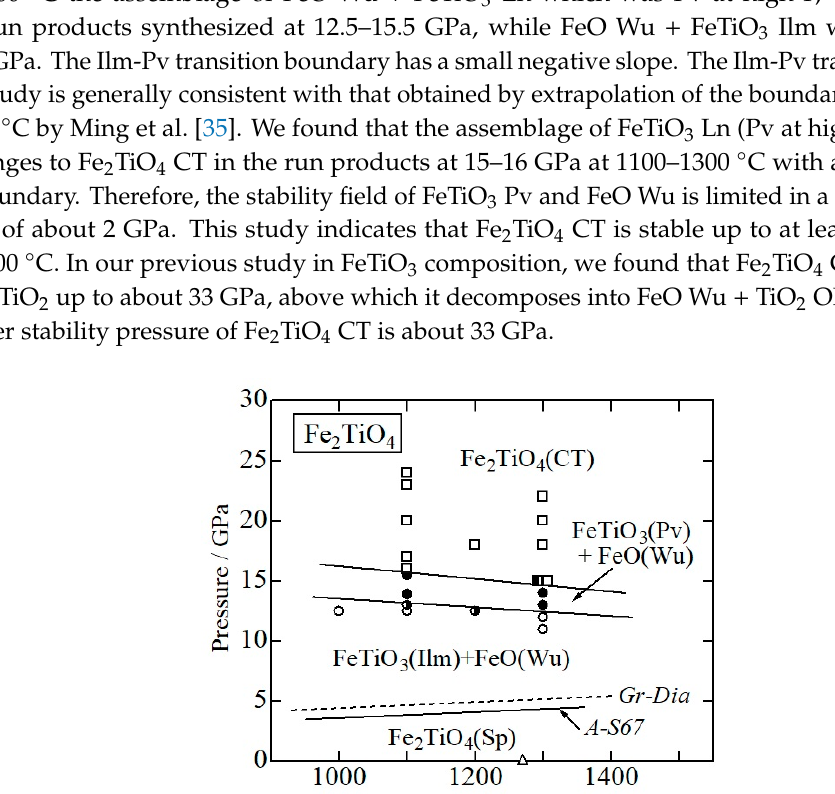
Figure 4. Phase diagram of Fe 2 TiO 4 . An open triangle: Fe 2 TiO 4 (Sp), open circles: FeTiO 3 (Ilm) + FeO(Wu), solid circles: FeTiO 3 (Pv) + FeO(Wu), open squares: Fe 2 TiO 4 (CT). Thick solid lines: this study, a thin line with A-S67: Sp dissociation boundary to Ilm + Wu [7], a thin dashed line with Gr-Dia: the graphite–diamond boundary [36]. Sp: spinel-type, Ilm: ilmenite-type, Wu: wustite, Pv: perovskite-type, CT: calcium